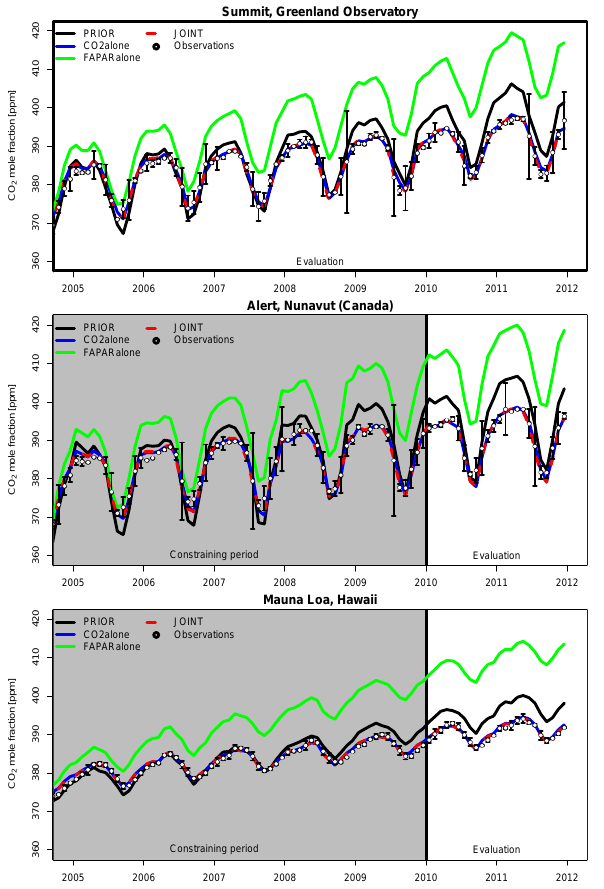
Figure 4. Time series of atmospheric CO 2 as observed at high- latitude evaluation site Summit and at two constraining sites, one at high latitudes (Alert) and one representative of the Northern Hemi- sphere (Mauna Loa) for the different prior and posterior models. The observations are given together with their uncertainty.